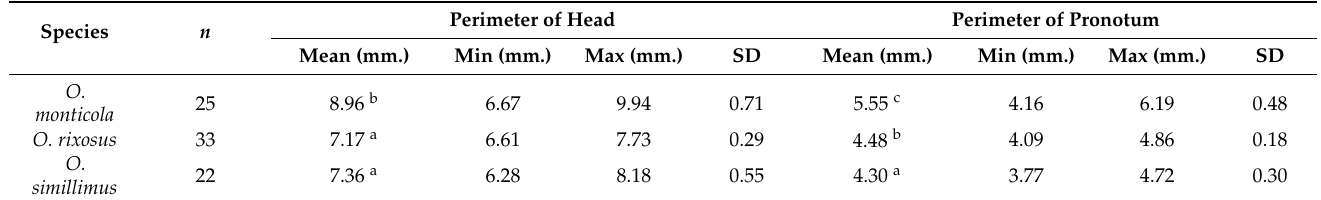
Table 1. Perimeter of head and pronotum contours of three Odontomachus